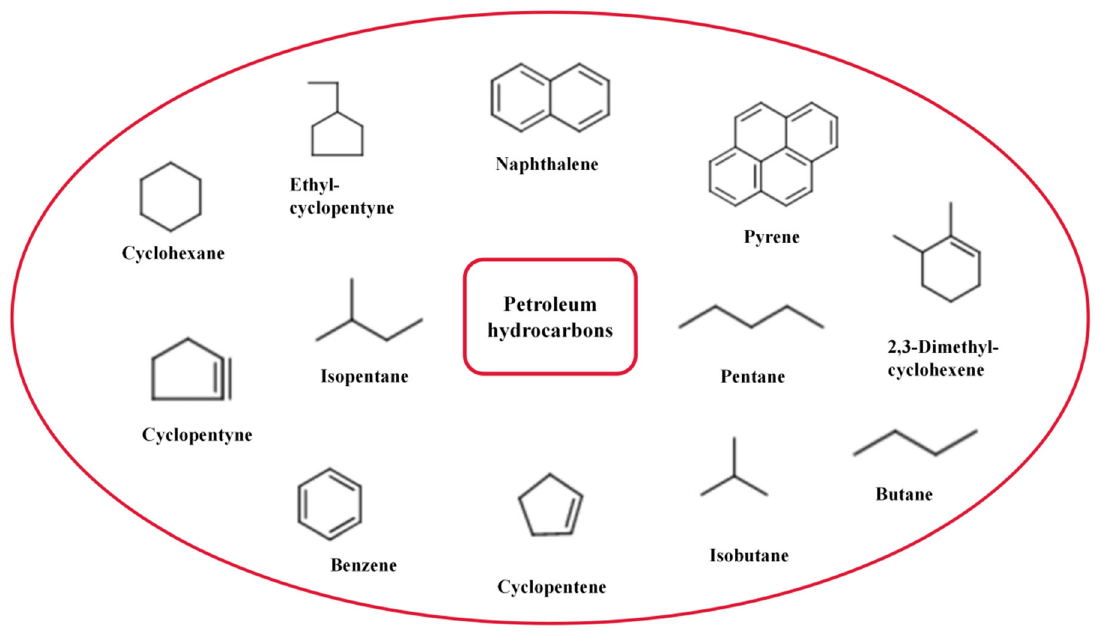
Figure 1. Main toxic PHCs in soil (created by author).